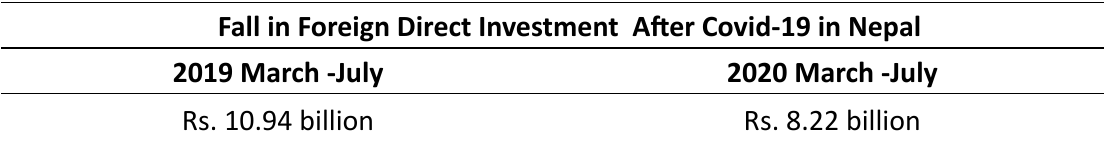
Table 2 : Fall in Foreign Direct Investment after Covid-19 in Nepal Fall in Foreign Direct Investment After Covid-19 in Nepal